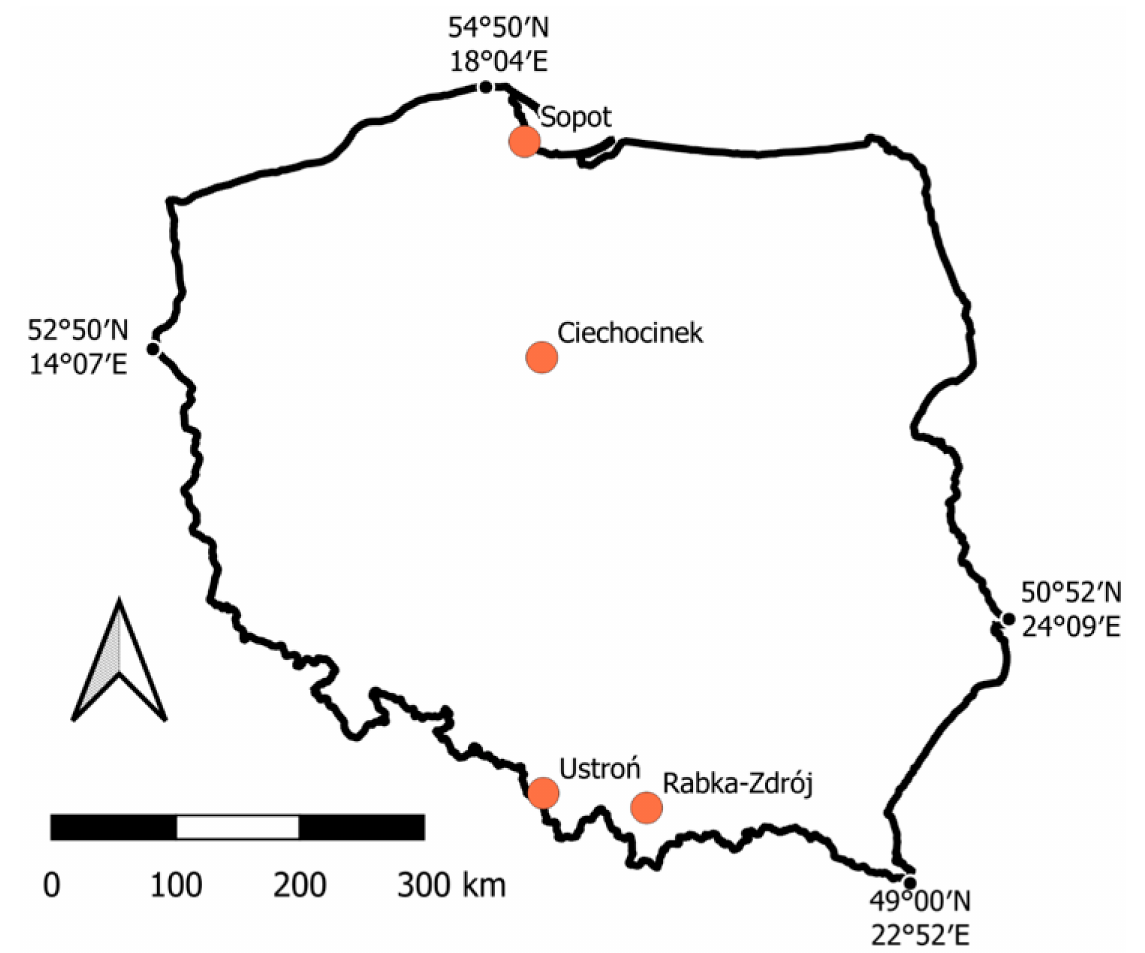
Figure 1. Location of studied health